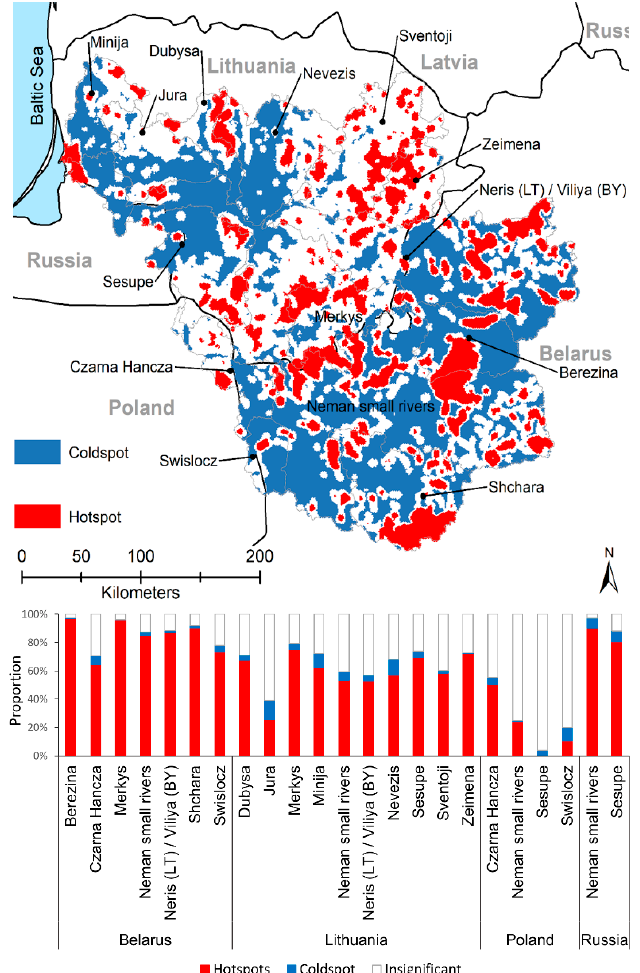
Figure 7. Map identifying peatland hotspots (red) and coldspots (blue) at the landscape scale for the Neman River basin. The graph at the bottom of the figure indicates the proportion of peatlands within the hot and cold spots for each sub-basin.